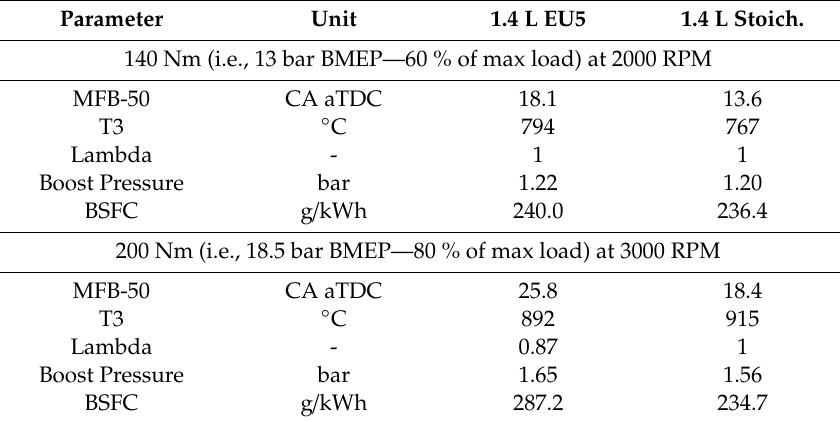
Table 7. Part Load comparison between 1.4 L EU5 and 1.4 L stoichiometric engine concepts. aTDC: after Top Dead Center; BMEP: Brake Mean E ff ective Pressure; BSFC: Brake Specific Fuel Consumption; CA: Crank Angle; T3: Turbine Inlet Temperature.